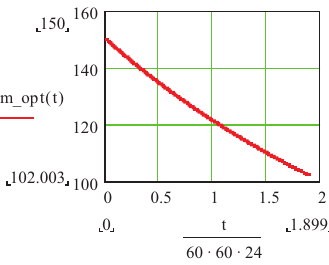
Figure 3. Optimal aviation fuel consumption as a function of the time for correspondent variable mass of the flying object The labeling of the respective axes in Figure 3 is as follows. The ordinate axis designation m_opt(t) stands for the values of m ( t ) obtained by equation derived for the opt dependence upon time with the use of the data of Eq. (11).